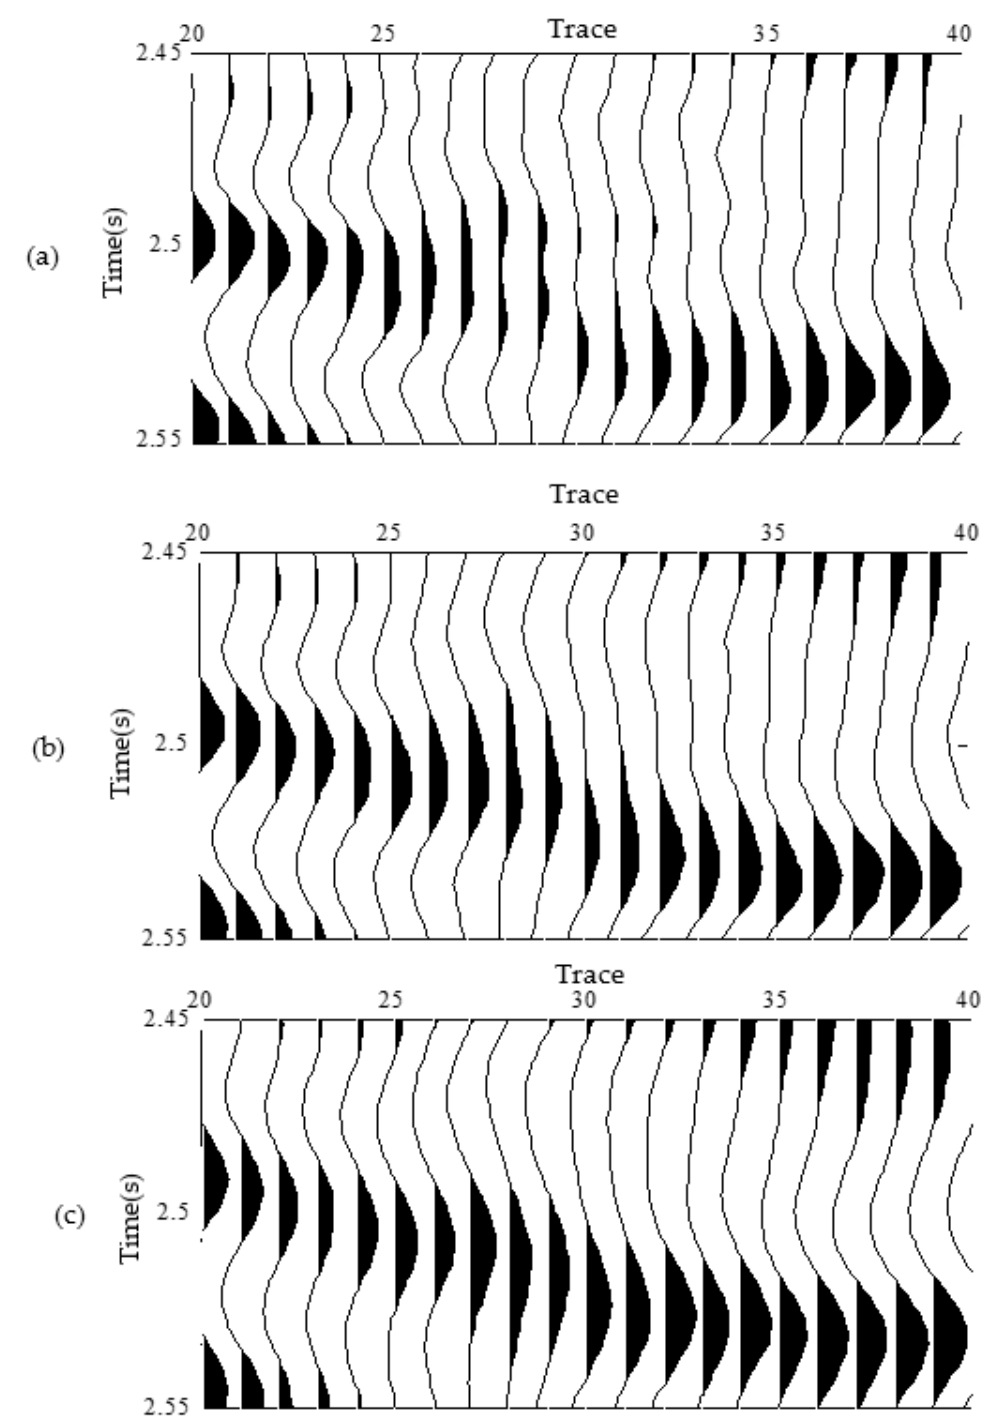
Figure 13. Partial enlargement effect at position B in 2–10 Hz filtering profile before and after low-frequency expansion. ( a ) Original data, ( b ) processed data by CS, ( c ) processed data by the proposed method.